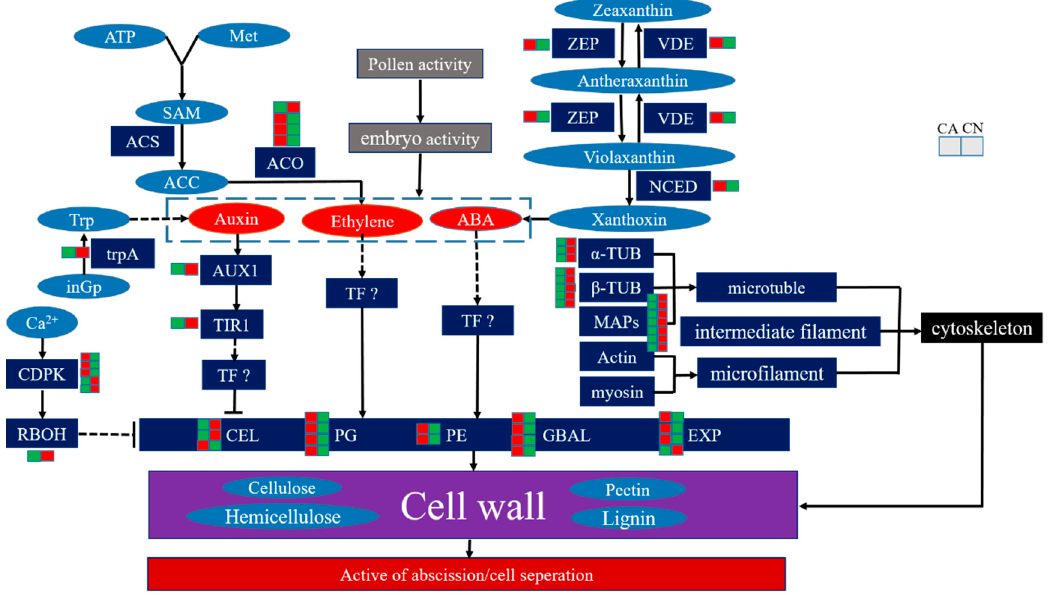
Figure 8. Model of abscission regulation. Red ovals represent hormones, dark blue represents enzymes or proteins, light blue ellipse represents compounds or ions, small red boxes represent up-regulated proteins, and small green squares represent down-regulated proteins.